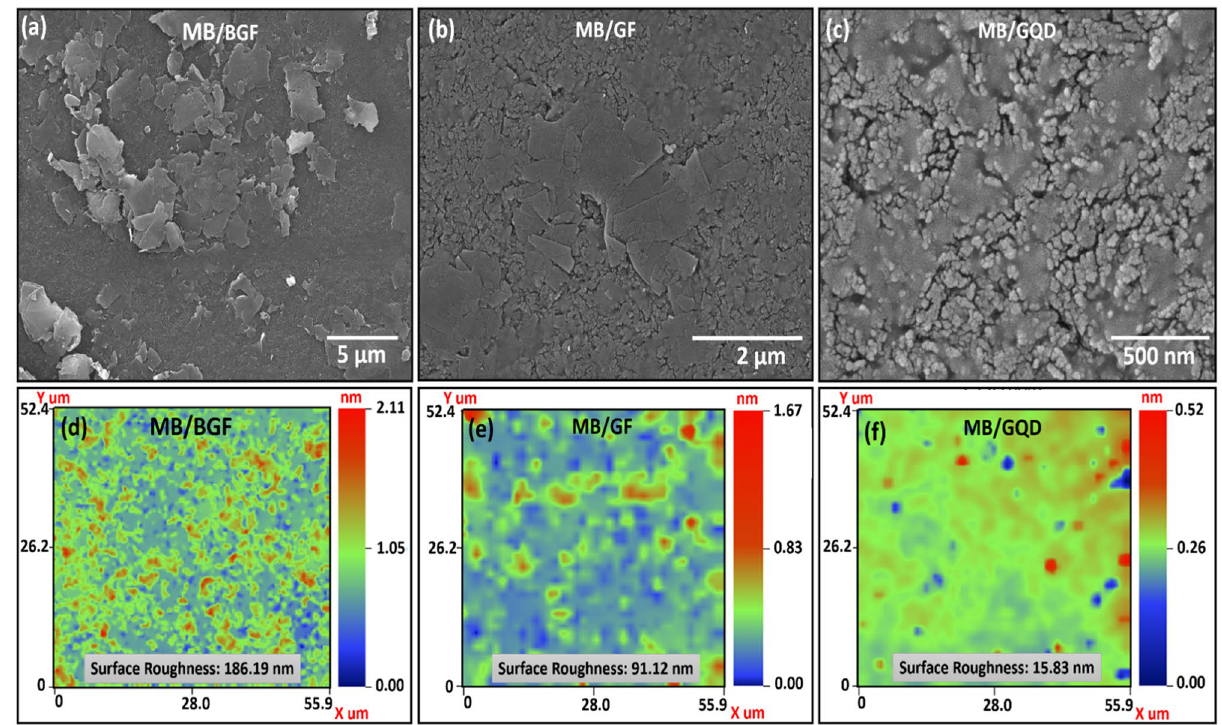
Figure 2. The Surface morphology of composite film, ( a ) MB/BGF at 5 μm showing Graphene flakes in bulk form in a composite film, ( b ) MB/GF composite film at 2 μm, and ( c ) MB/GQD film at a magnification of 500 nm, respectively. The 2D Nano profile of composite films, ( d ) MB/BGF, ( e ) MB/GF, and ( f ) MB/GQD to confirm the surface